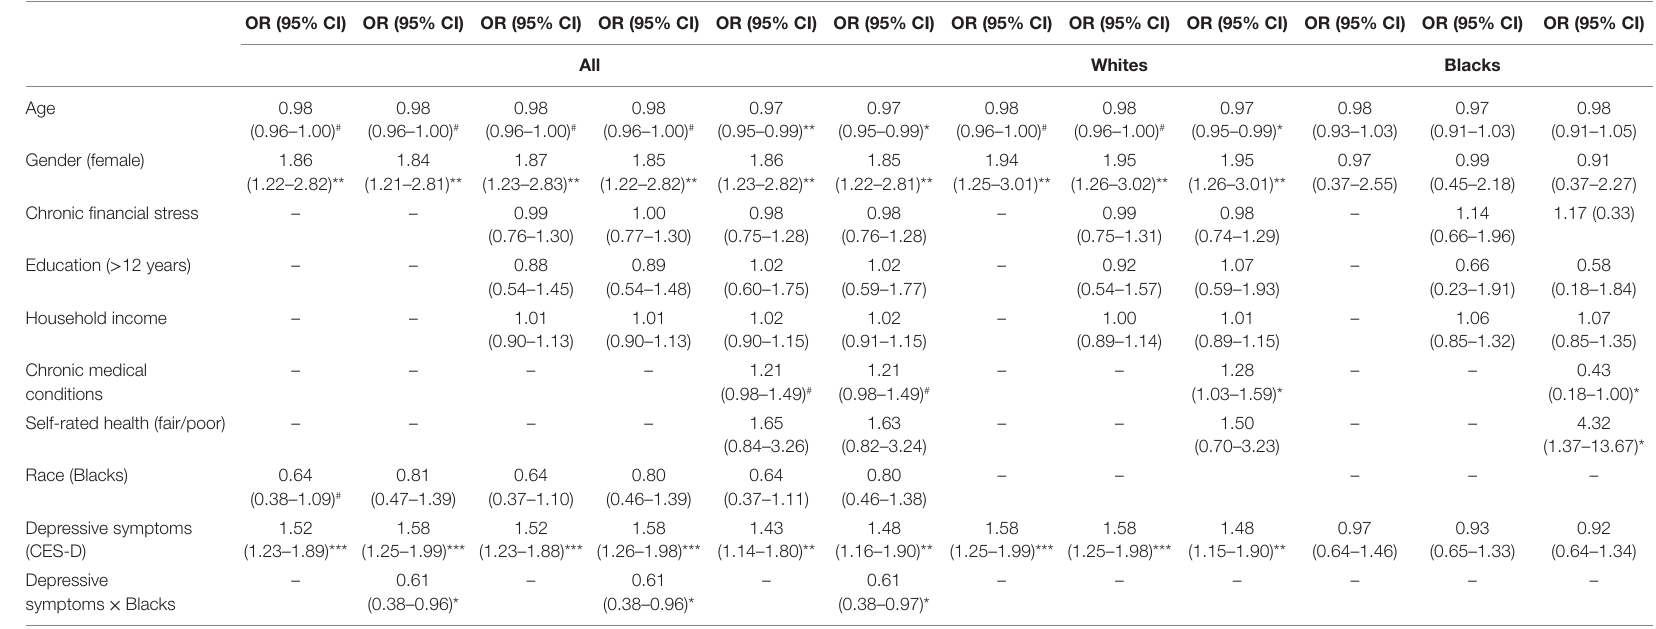
TaBle 2 | summary of logistic regression models on the association between baseline ces-D scores and ciDi-based depression after 15 years based on